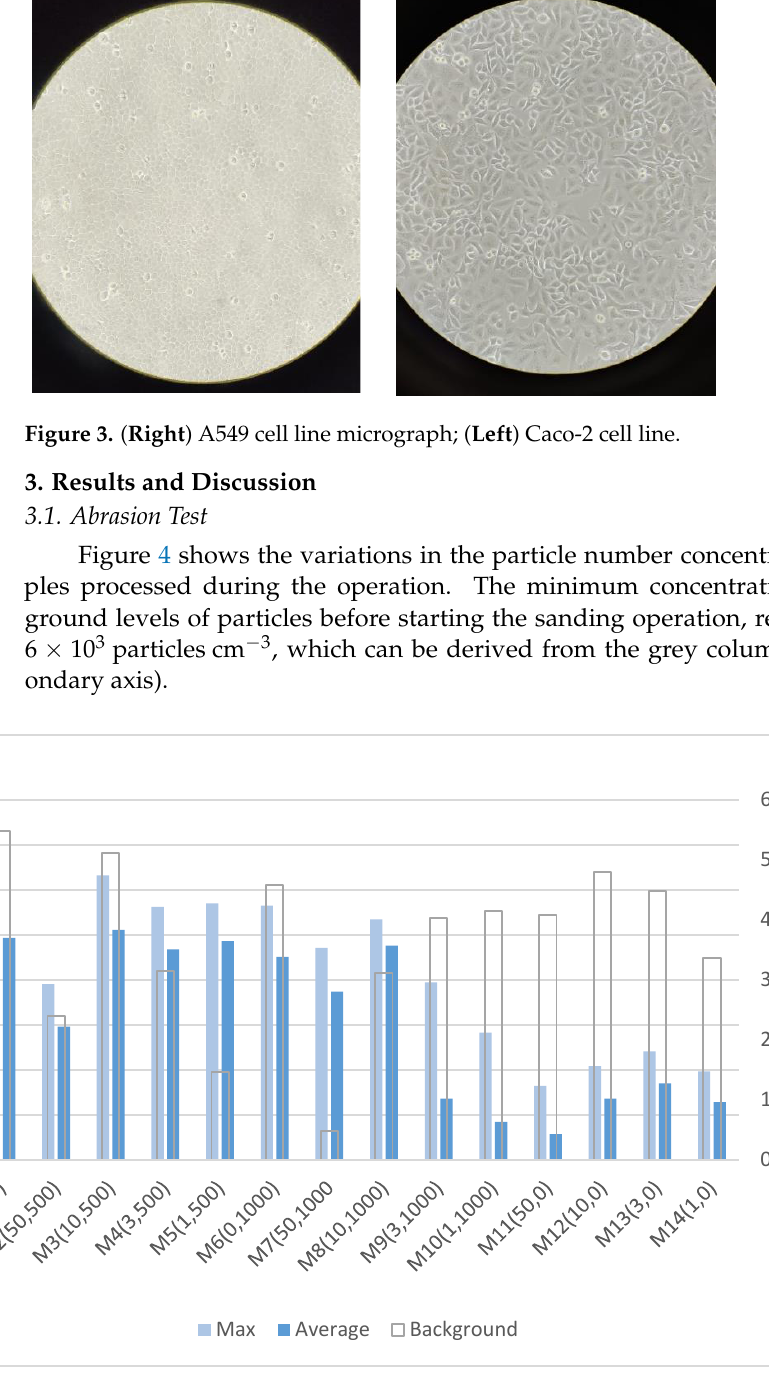
Figure 4. Concentration of particles measured with a CPC during the sanding activity. Maximum and average concentration values are referred to along the Y axis.